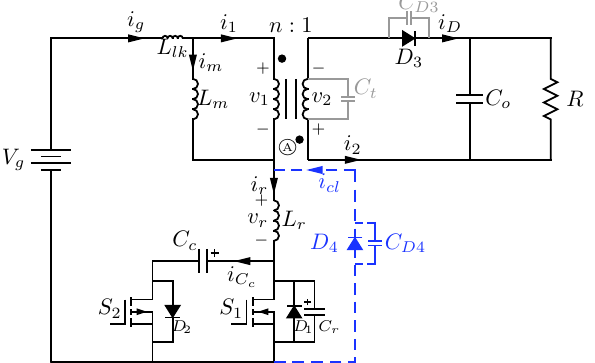
Figure 5. Enhaced ACF converter with parasitic elements and the proposed clamp (dashed